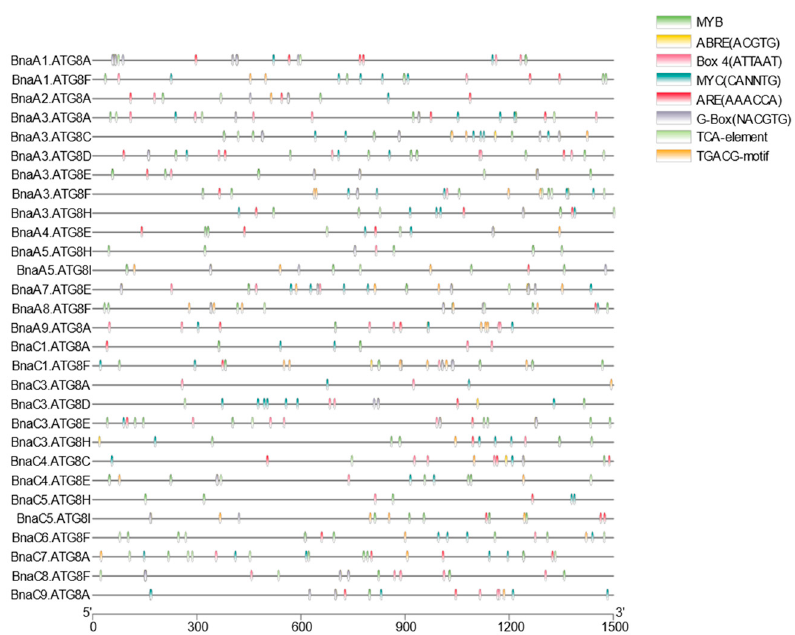
Figure 2. Identification of the putative cis -acting regulatory elements (CREs) of the 1.5-kb genomic sequences upstream of the start codon (ATG) of the ATG8 family genes in B. napus . Genomic distribution and relative abundance of the eight most CREs in the BnaATG8 promoters. Different CREs are indicated with different